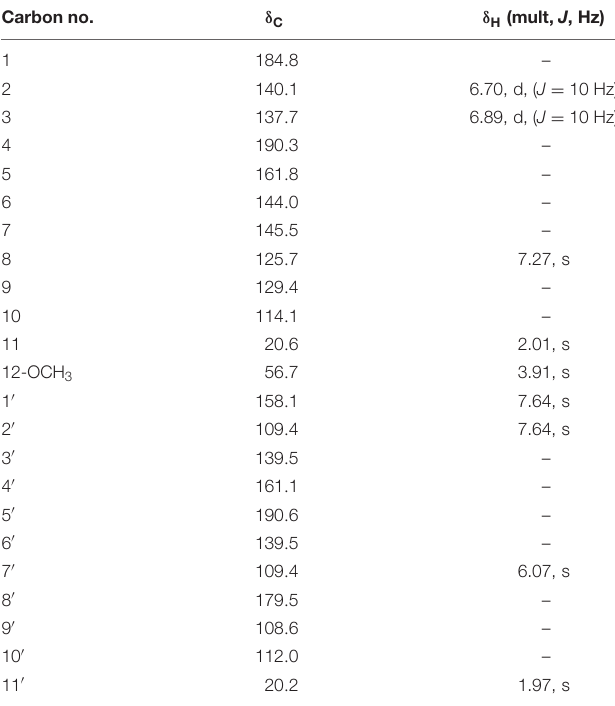
TABLE 1 | 13 C-NMR and 1 H-NMR spectral data of compound 1. Carbon no.